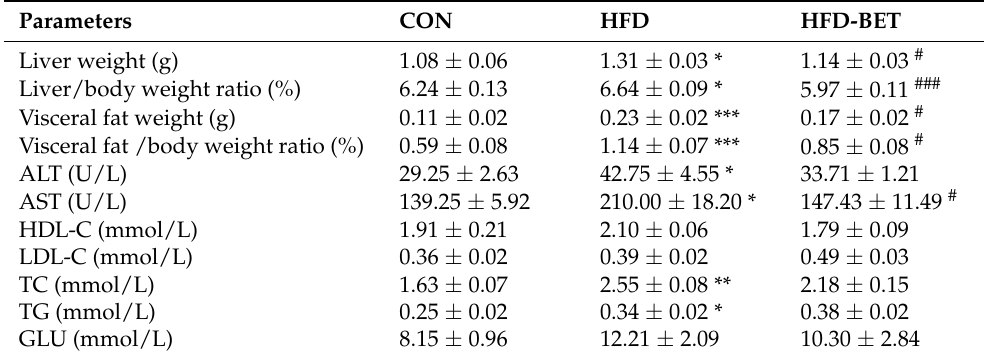
Table 2. Effects of maternal betaine supplementation on organ coefficients and serum biochemical parameters in offspring